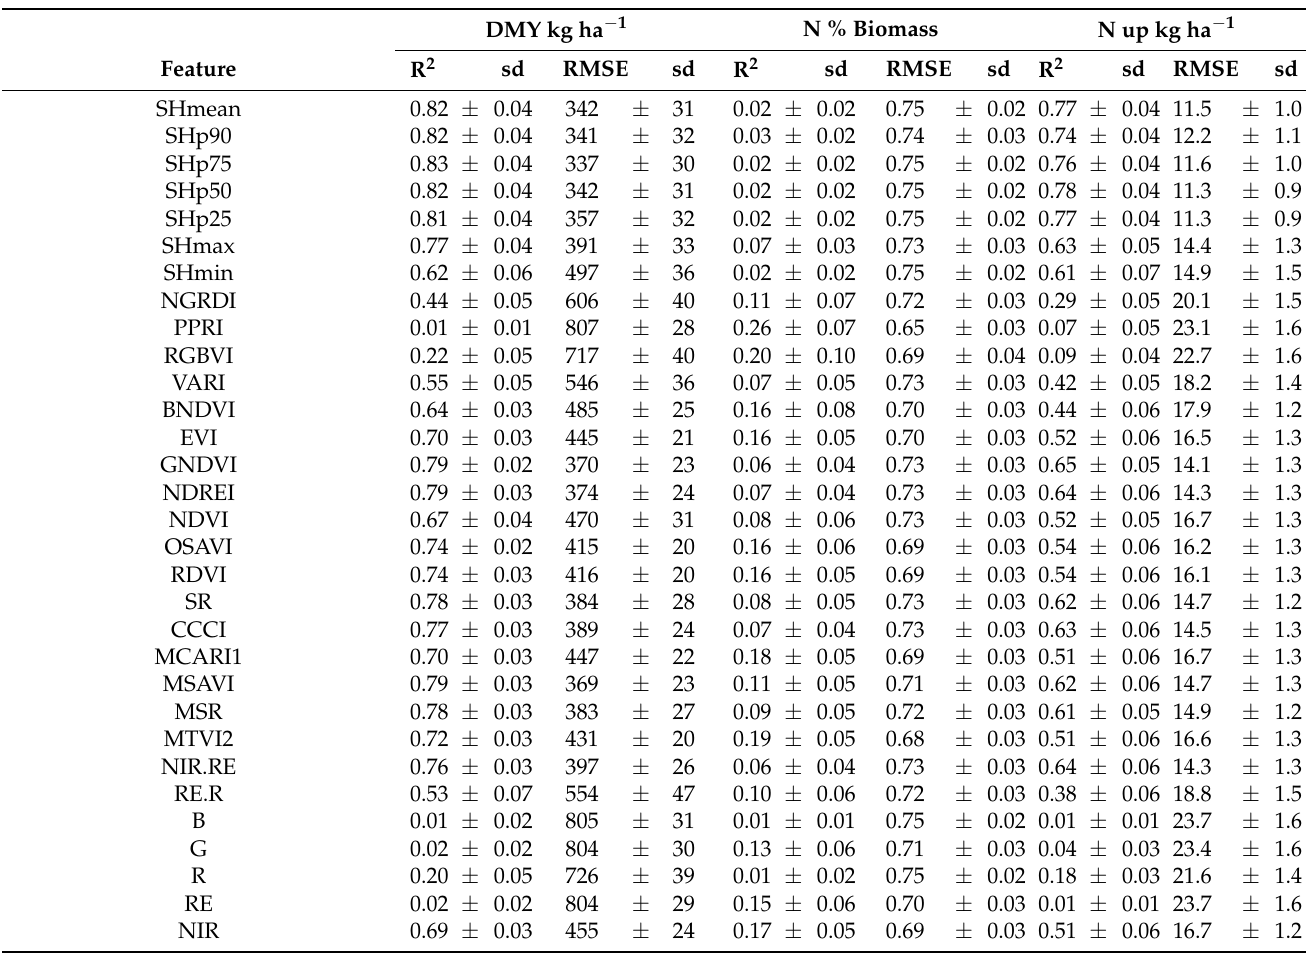
Table A1. Cross-validation Regression results simple linear regression for all